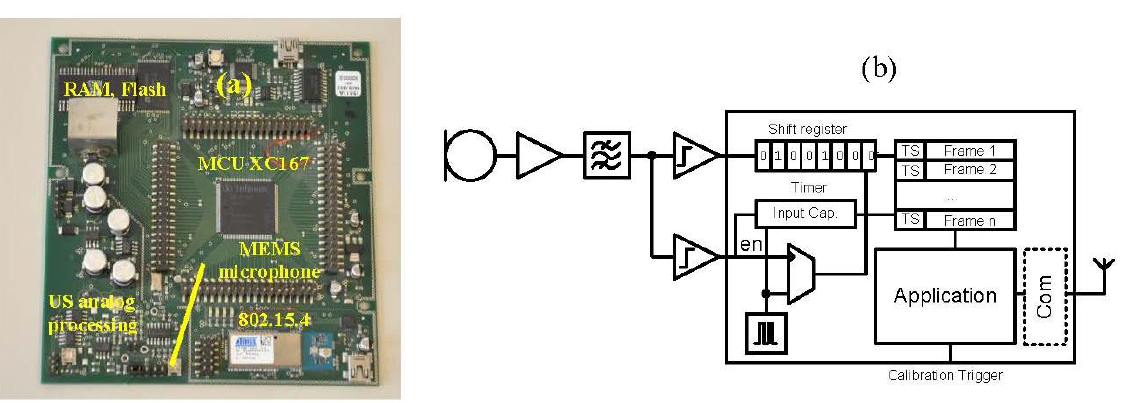
Figure 21. ( a ) Picture showing a test realization of a sensor node with a ZigBee communication interface. ( b ) Suggested software architecture for